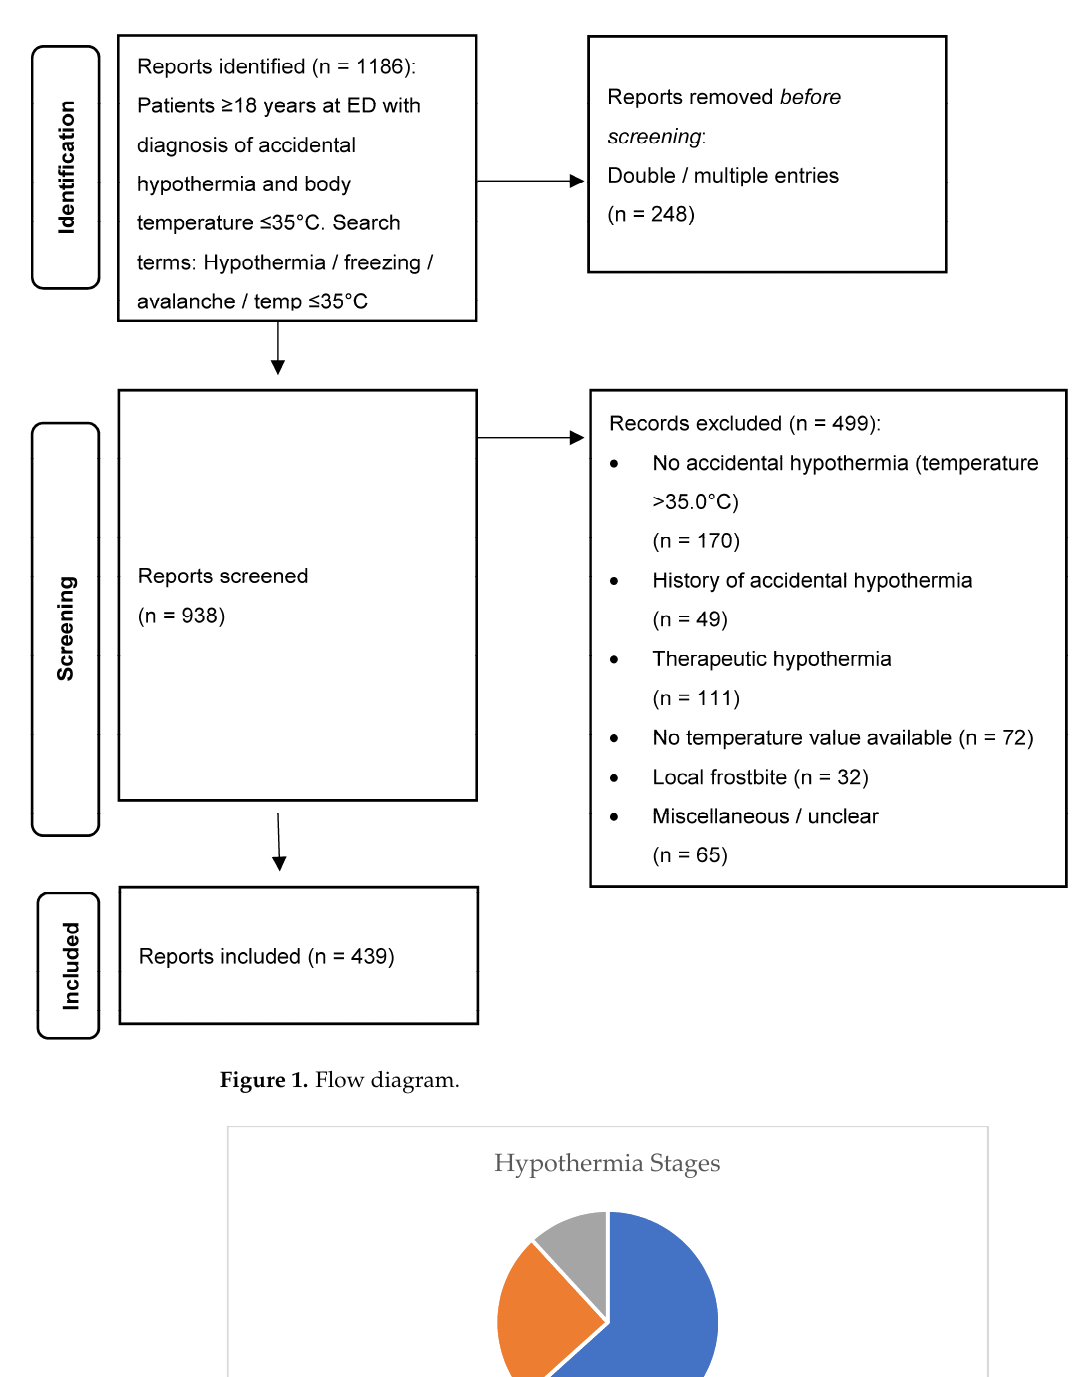
Figure 2. Hypothermia stages.